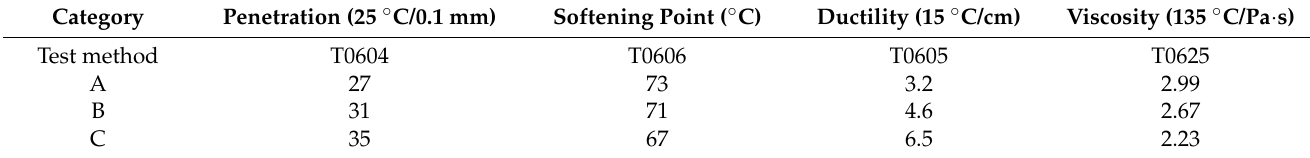
Table 1. The technical indicators of aged asphalt.